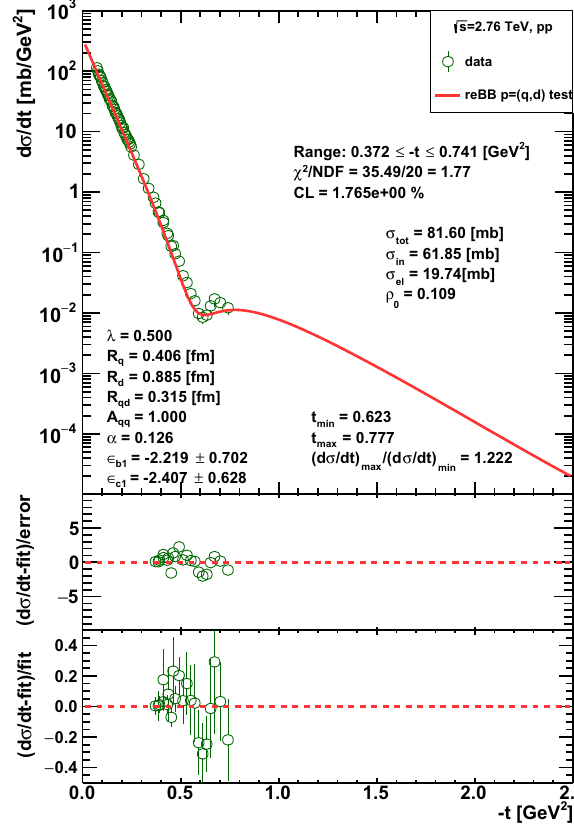
√ s = 1 . 96 Fig. 12 Result of a sanity test, same as Fig. 8, but for the TeV pp elastic differential cross section data [9] in the range of 0 . 37 ≤ − t ≤ 0 . 7 GeV